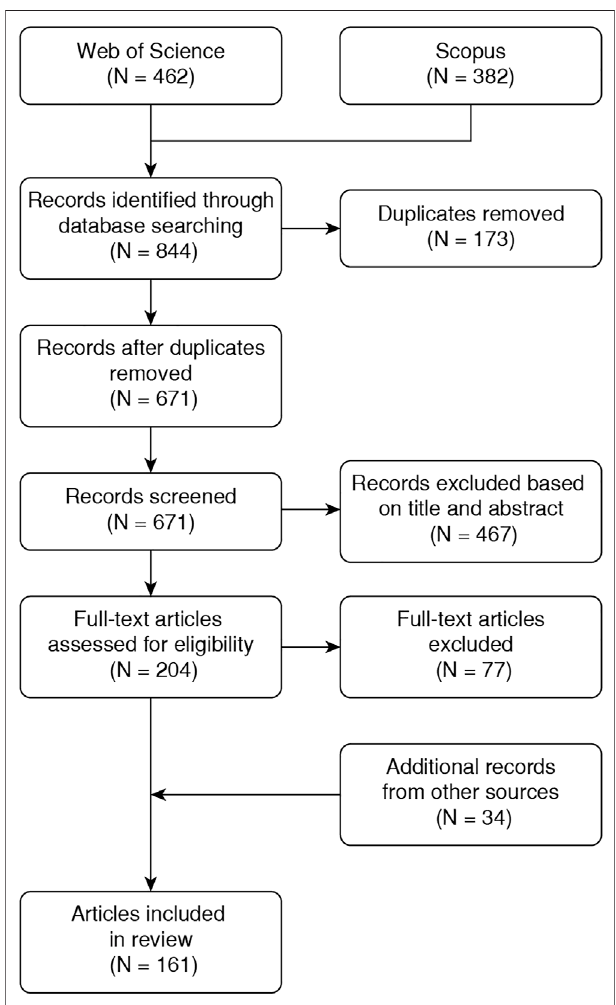
FIGURE 1 | Flow diagram of the literature search methodology for document selection.